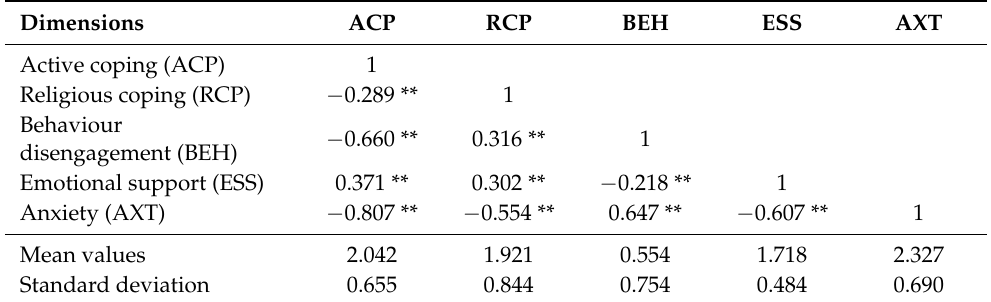
Table 7. The relationships between Coping Measures and Anxiety Measures and Descriptive